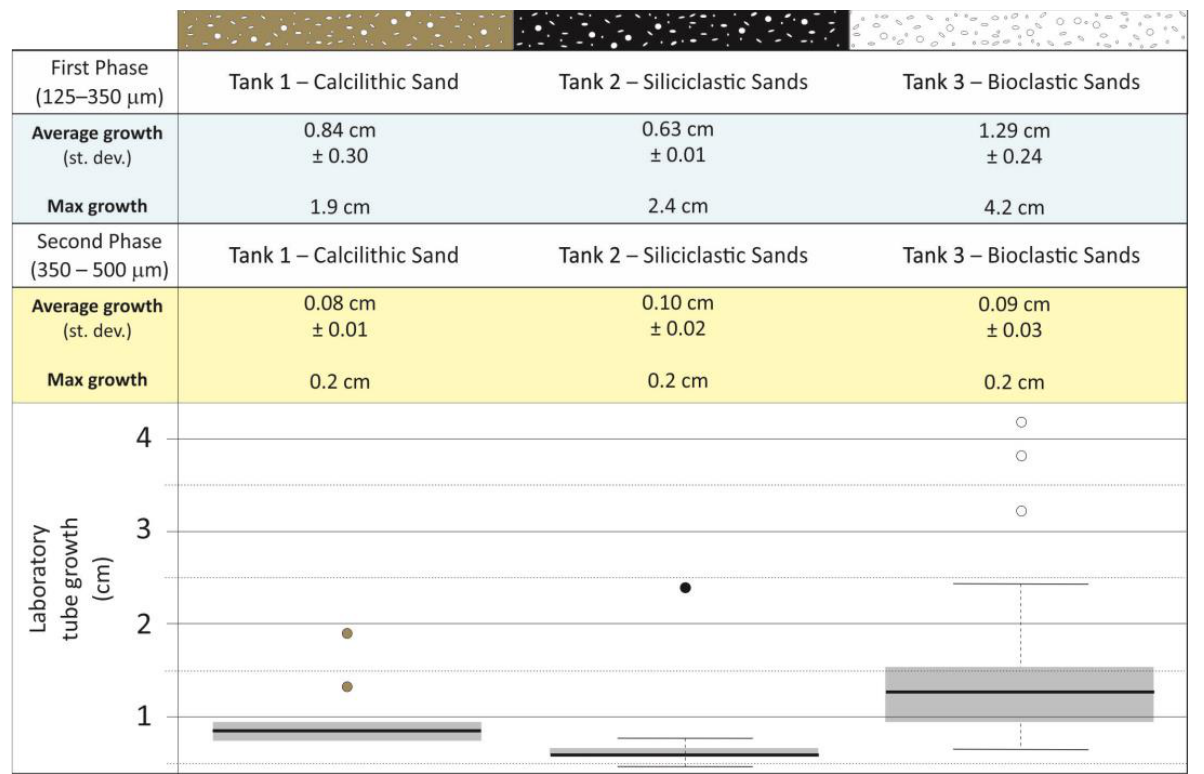
Figure 7. Summary of tube growth during the experiment: the average and maximum values measured in the first and second phases in each tank are shown. Below, the statistical distribution of the measured growths during the first phase in the different tanks (1, 2, and 3) is reported. Box plots show the variability and distribution of the data; the average values for each tank are represented by the black lines, and the colored dots represent the extreme values measured in each tank.